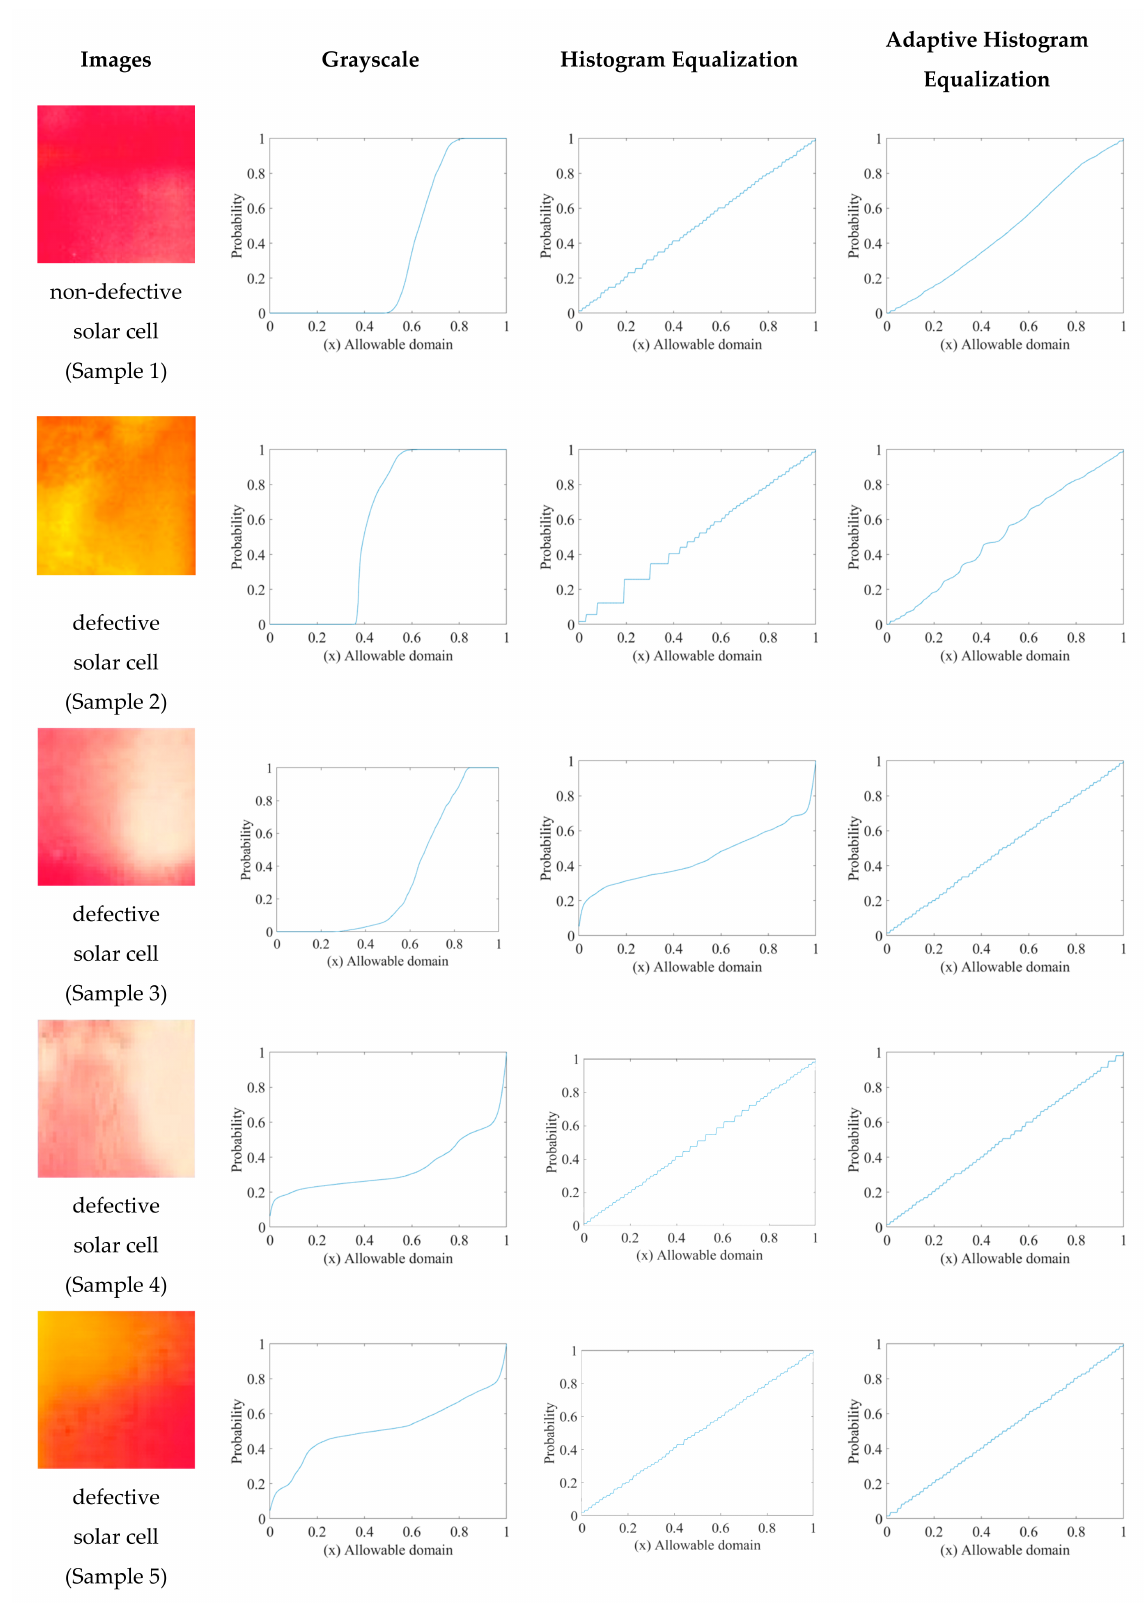
Figure 20. Simulated CDF comparison on different thermal solar cell condition with non-defective (panel 1) and defective solar cells (panel